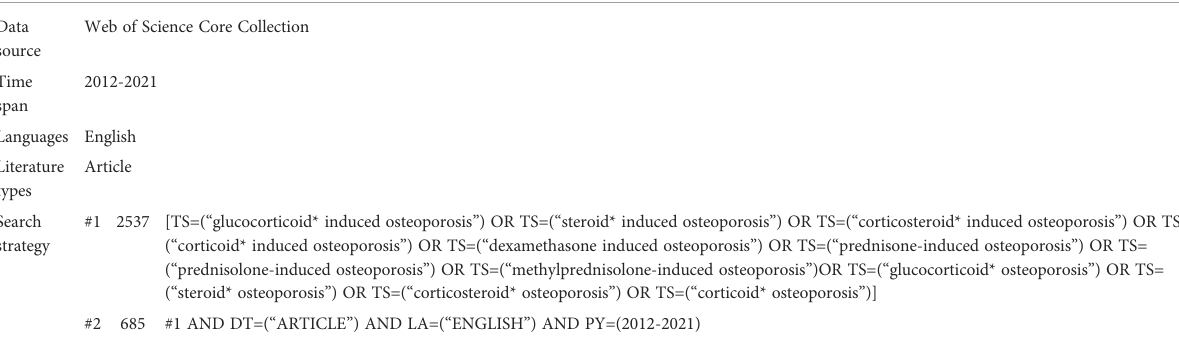
TABLE 1 Summary of data selection strategy in this